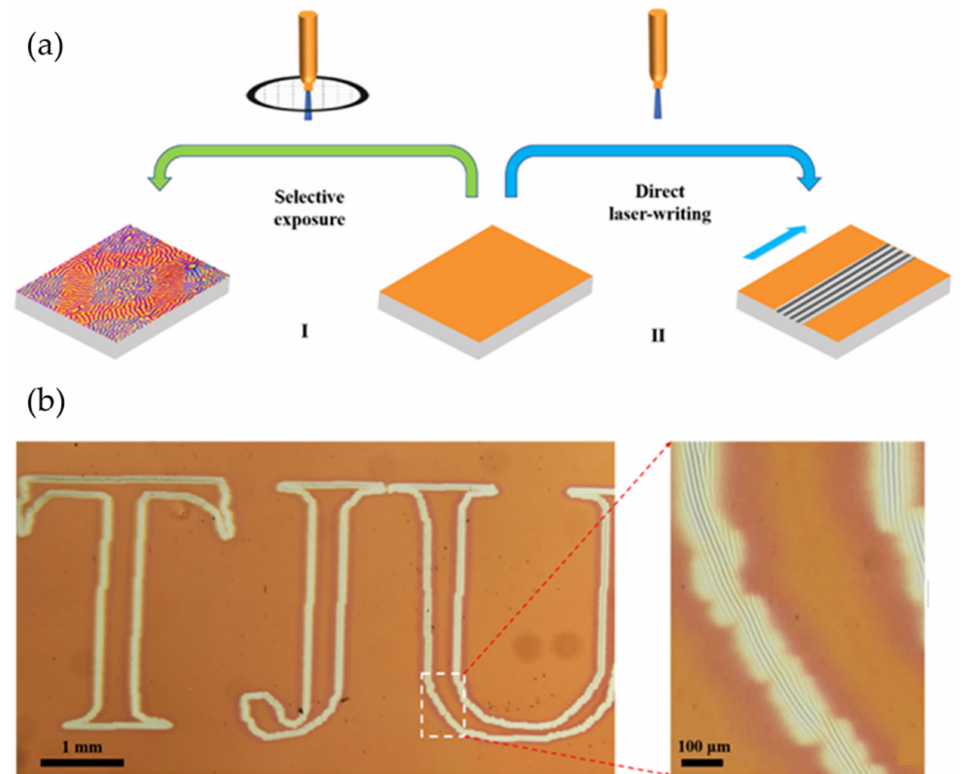
Figure 8. ( a ) Representative schematic of the wrinkle-inducing pathways upon exposure of a (PDO 3-PS)/PDMS bilayer to a 450 nm laser with a photomask (I) or a moving laser (II) and ( b ) Optical image of trajectory-guided oriented wrinkling (TJU) of (2% PDO3 - 2% PS)/PDMS induced by a moving high-intensity laser beam (e.g., 16.20 W-cm − 2 /1.0 mm-s − 1 ). Reproduced with permission from reference [54]. Copyright 2022,